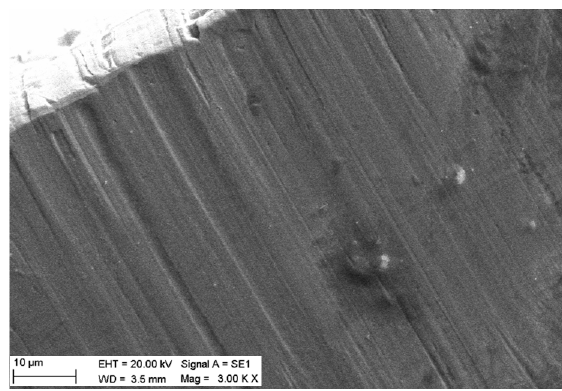
Figure 2. SEM micrographs of the cross section of the Pd 30 Ag 70 sample.